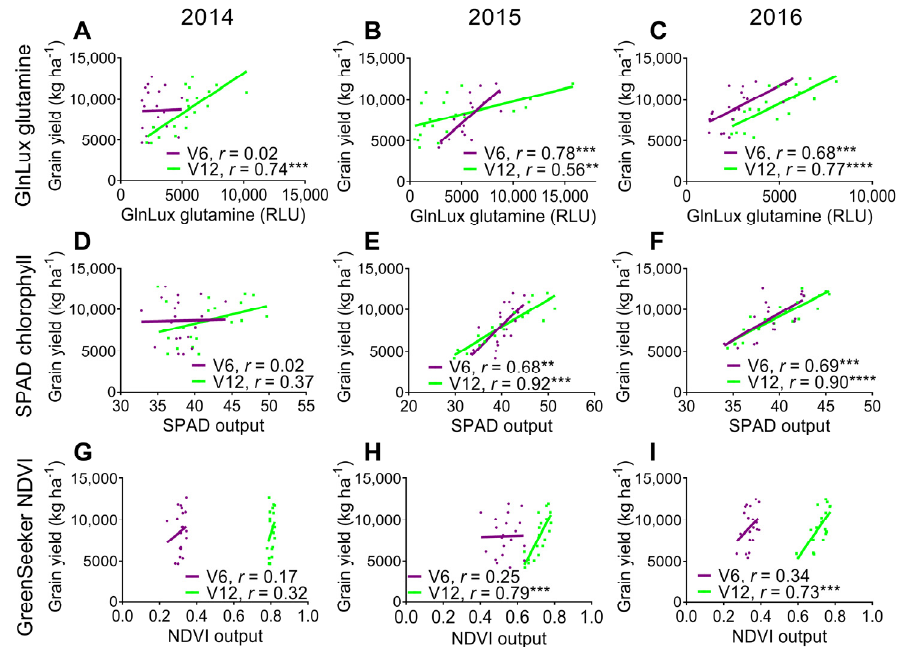
Figure 2. Correlation of end-season maize grain yield (kg ha − 1 ) and ( A – C ) GlnLux glutamine; ( D – F ) SPAD; and ( G – I ) NDVI output. Maize was provided with N application rates of 30, 58, 87, 145, or 218 kg ha − 1 . All measurements were recorded at the V6 and V12 growth stages in 2014, 2015, and 2016. Asterisks represent significant Pearson correlations at p < 0.05, <0.01, <0.001, and <0.0001. RLU, relative light units intercepted by the luminometer in a one second interval.